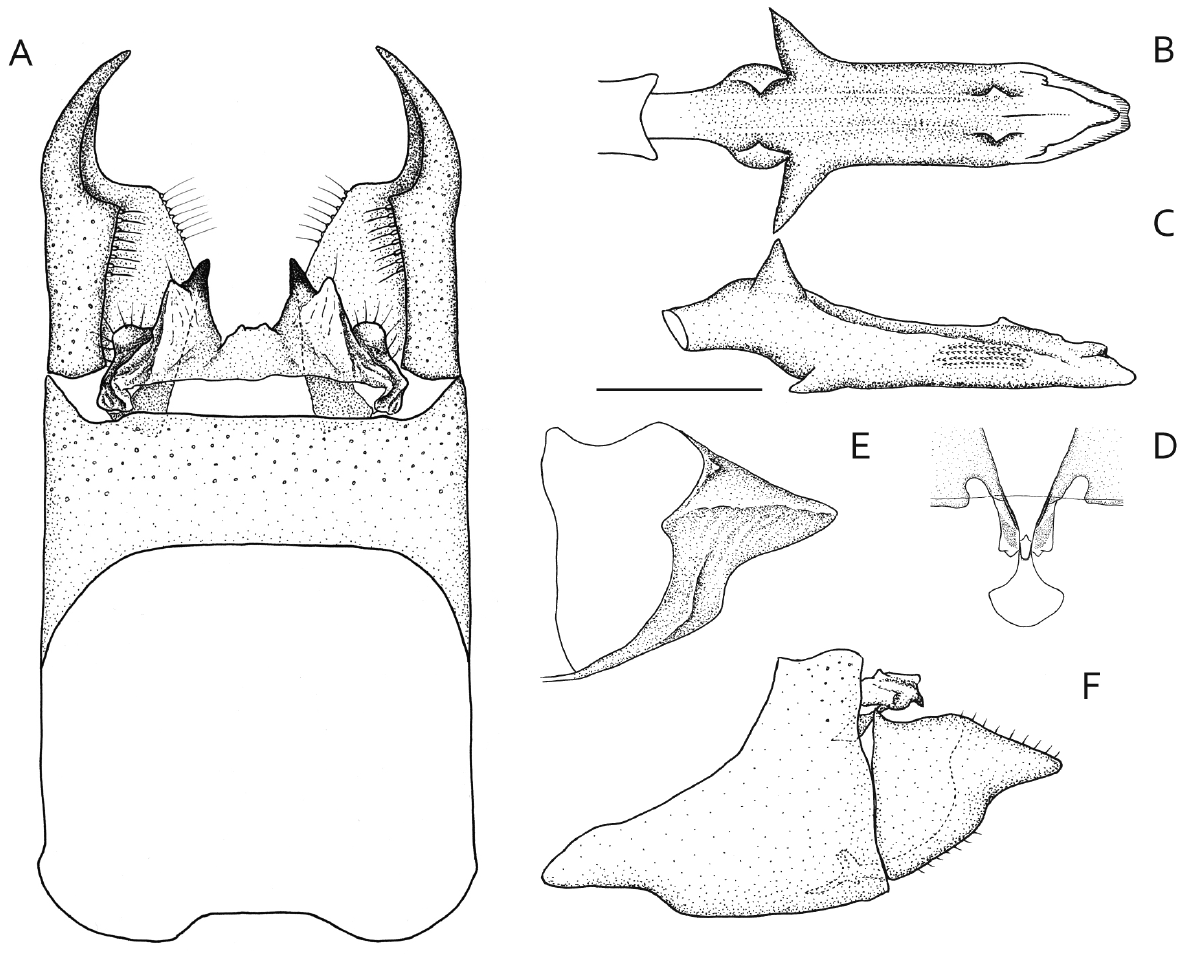
Figure 8. Male genitalia of Issikiomartyria hyperborea sp. n. [holotype]. A: genitalia capsule, dorsal view; B: phallus, dorsal view; C: ditto, lateral view; D: median plate; E: left valva, inner view; F: genital capsule, lateral view. Scale bars: 0.2